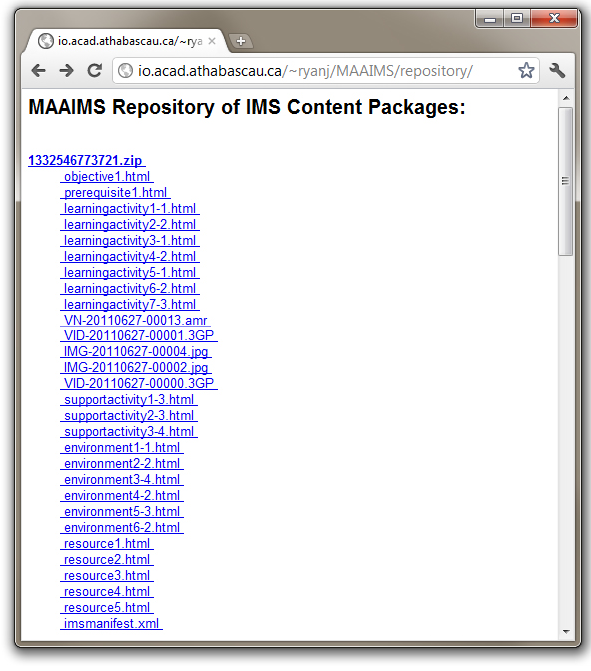
Figure 5 . A MAAIMS repository entry of a content package containing a learning